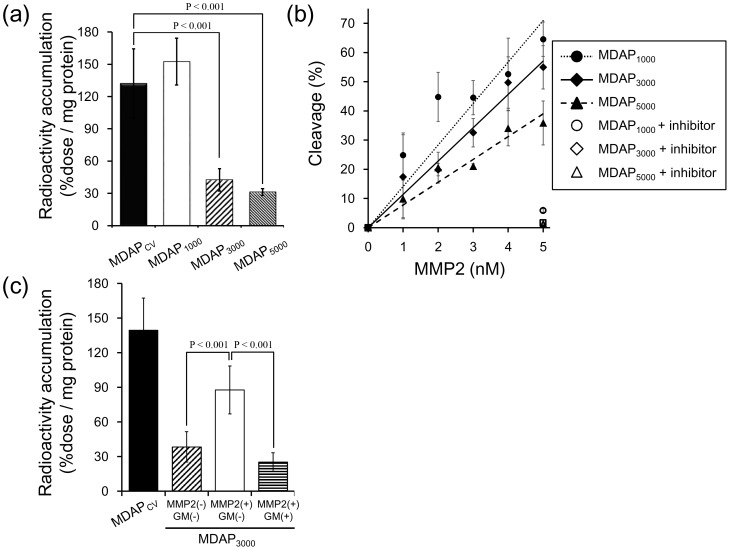

In vitro experiment.(a) Cellular accumulation of MDAP1000, MDAP3000, MDAP5000 and MDAPCV estimated by radioactivity counting. (b) Cleavage (%) of MDAP1000, MDAP3000, and MDAP5000 arising from MMP-2 treatment. Values were estimated by reverse phase HPLC. (c) Cellular accumulation of MDAP3000 with or without MMP-2 protein and MMP inhibitor (GM6001).